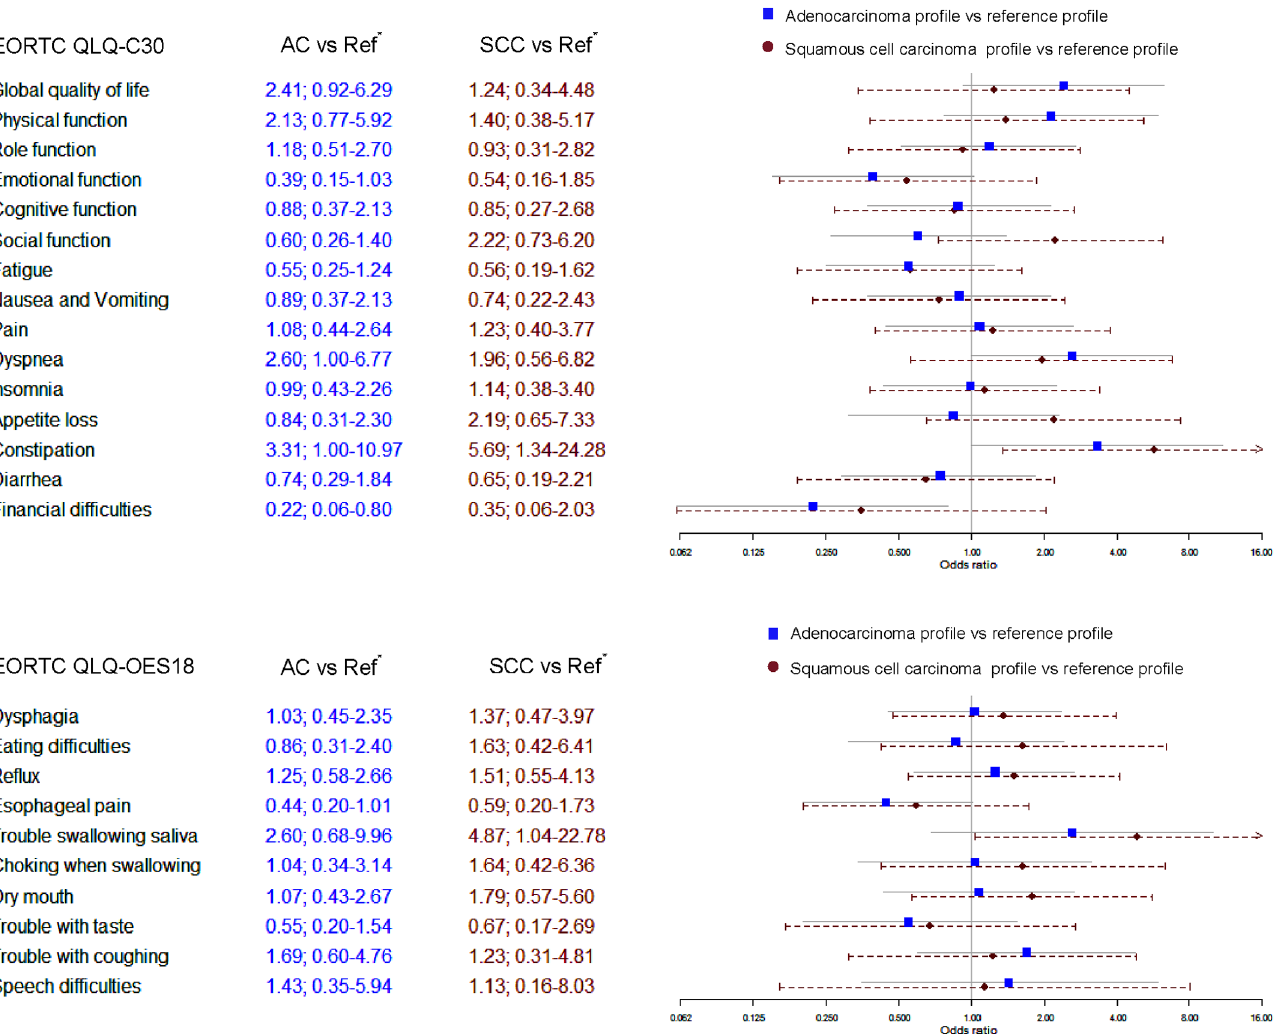
Fig 2. Graph illustrating association between the three patient profiles created from latent class cluster analysis and risk of deterioration in healthelated quality of life (HRQOL) aspects assessed by multivariable logistic regression analysis adjusted for age, BMI, tumour stage and marital status in patients who survived at least 3 years after surgery for oesophageal cancer. The blue squares represents odds ratio obtained from adenocarcinoma profile versus the reference profile and grey lines represent the confidence intervals. Red dots represent odds ratio obtained from the squamous-cell carcinoma profile versus the reference profile and dotted red lines represent confidence intervals. HRQOL was assessed at 6 months and 3 years from surgery using the European Organisation for Research and Treatment of Cancer questionnaires QLQ-C30 and QLQ-OES18. Scores obtained were converted into linear scale scores of 0 to 100 and mean score differences of (cid:21) 10 between scores at 6 months and 3 years were considered clinically moderately relevant and (cid:21) 20 as clinically strongly relevant. HRQOL of patients were also categorised as improved and stable/deteriorated for each aspect of HRQOL. Latent class cluster analysis of patient’s socio-demographic, anthropometric and clinical characteristics at diagnosis yielded three patient profiles: Reference profile: Younger age, male gender, upper secondary education, employed, cohabitating, urban dwellers. Adenocarcinoma profile: Unemployed/retired, male gender, low education, cohabitating, adenocarcinoma, higher tumour stage, lower oesophagus and cardia, co-morbidities present. Squamous-cell carcinoma profile: Unemployed/retired, male gender, low BMI, unemployed, urban dwellers, squamous cell carcinoma, upper and middle oesophagus. AC—Adenocarcinoma; SCC—Squamous–cell carcinoma; EORTC—European Organisation